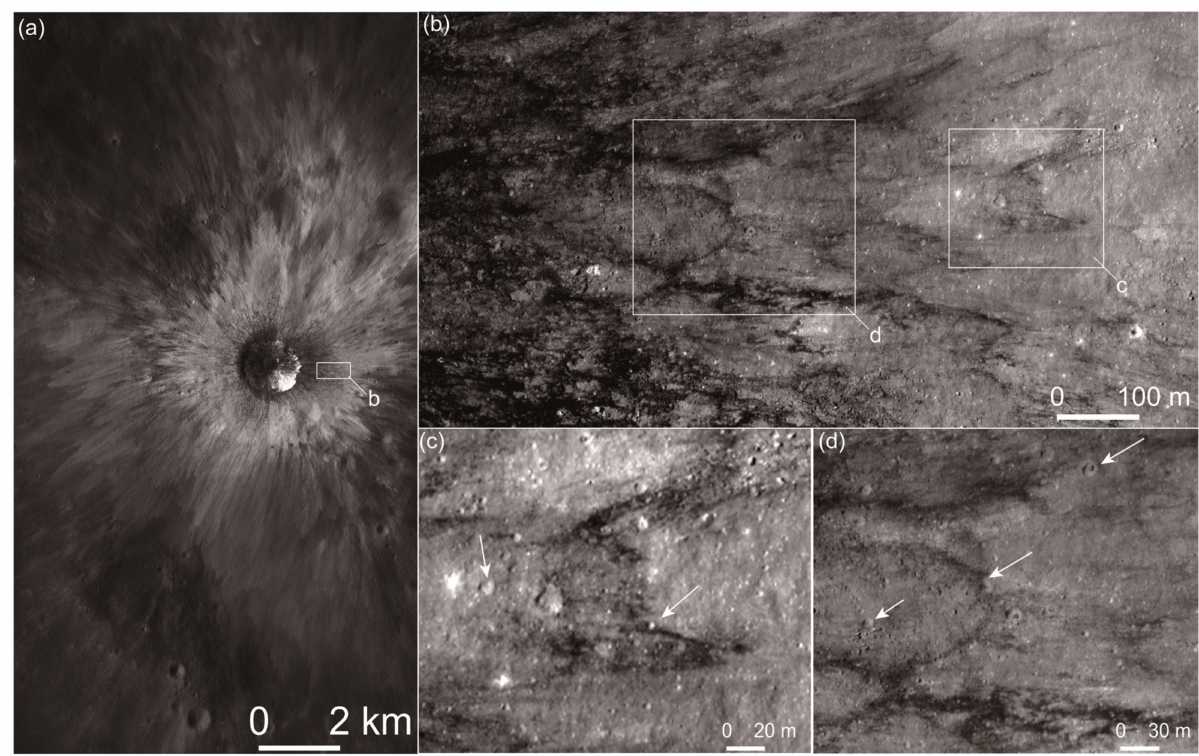
Figure 1. Self-secondaries around a cold spot crater ( D = 1442 m) that is centered at 151.68 ◦ E, 4.08 ◦ S. Solar illumination is from the left, and north is up in all the panels. ( a ) Layers of ejecta deposits are visible around crater rim, and they have different reflectances. ( b–d ) Crosscutting relationships between layers of ejecta and self-secondaries. Location of ( b ) is indicated in ( a ) and locations of ( c,d ) are indicated in ( b ). Self-secondaries (white arrows) formed on ejecta layers that were emplaced earlier were transected by subsequently arrived flows, suggesting a continuous landing of fragments during the emplacement of ejecta. IDs of data used in this figure are compiled in the Supplementary